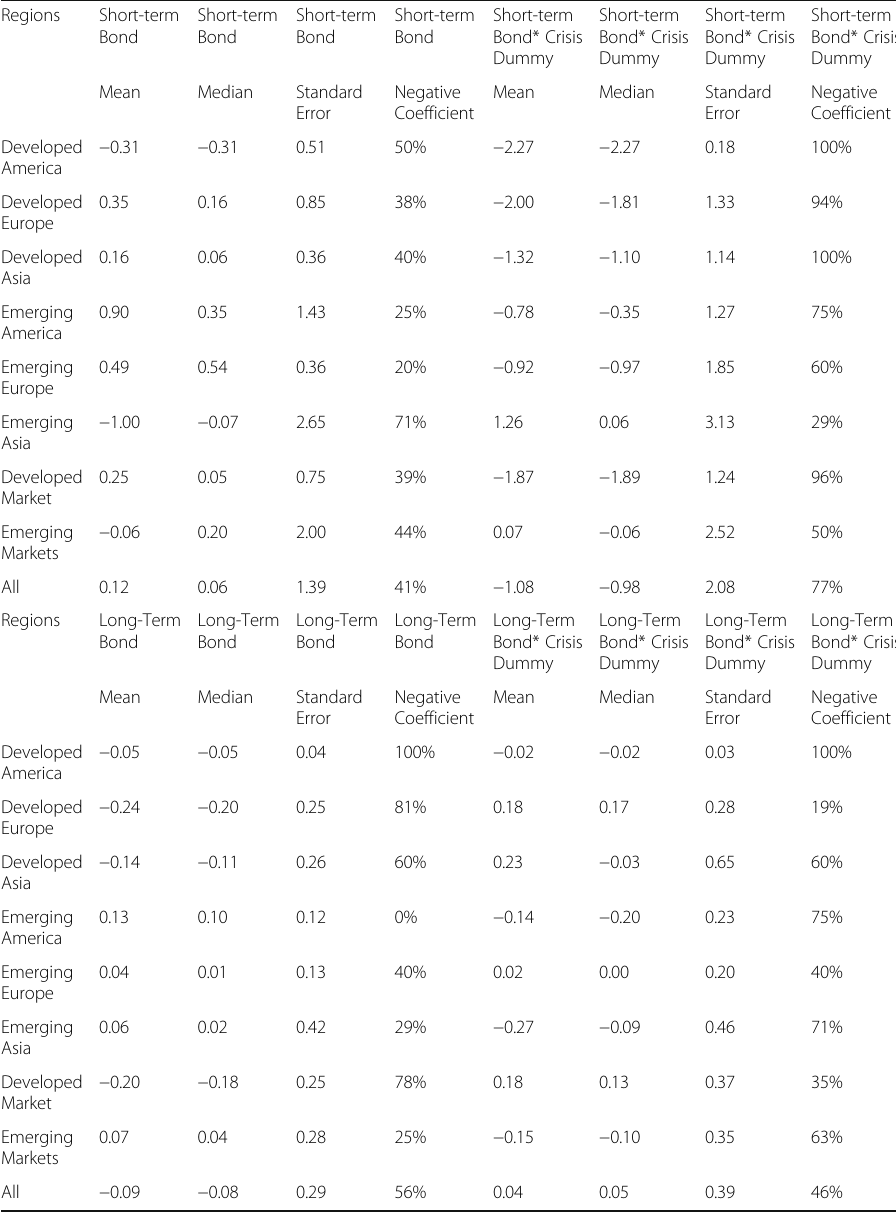
Table 6 Statistics to the results of Formula 2